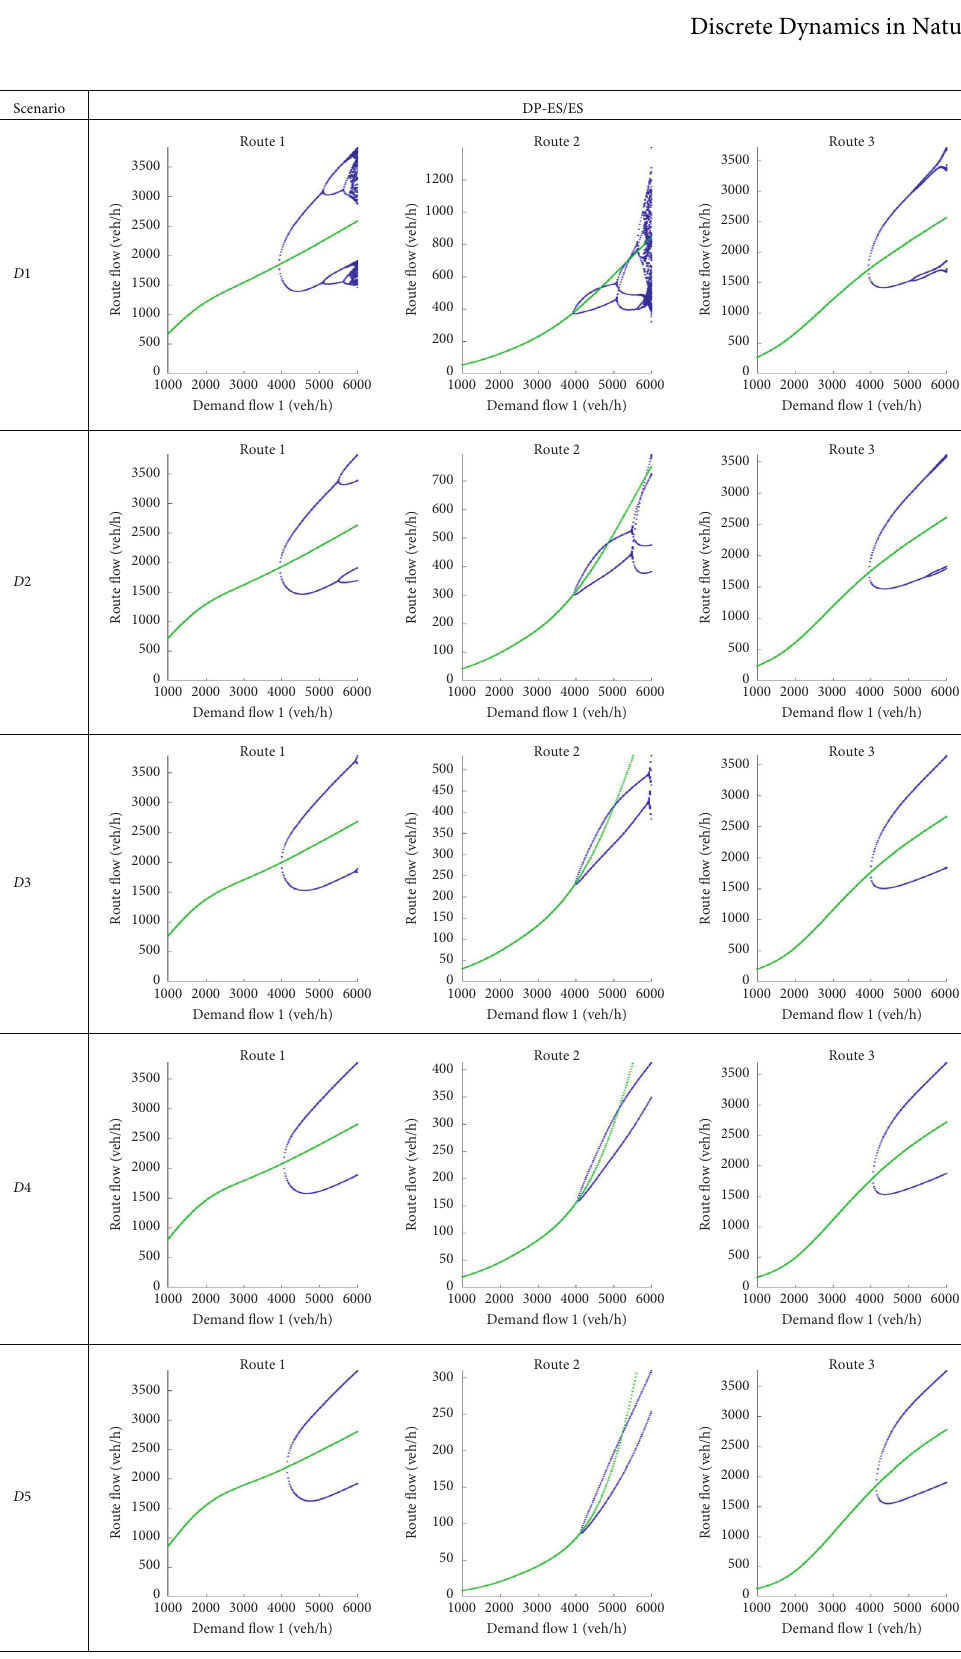
Figure 6: Bifurcation demand flow, AVs scenarios C: θ